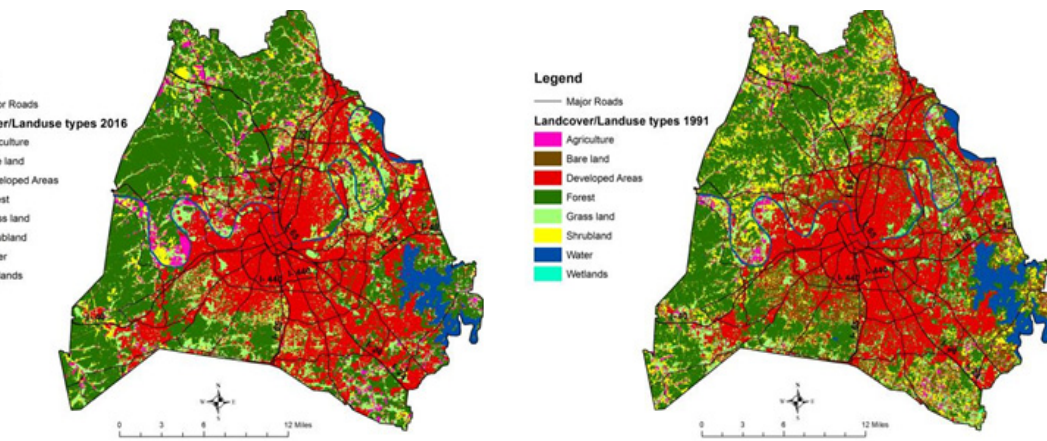
Fig. 4: Derived land cover/land use classes and distribution within Davidson County (September 1991) Fig. 3: Derived land cover/ land use classes and distribution within Davidson County (June 2016)